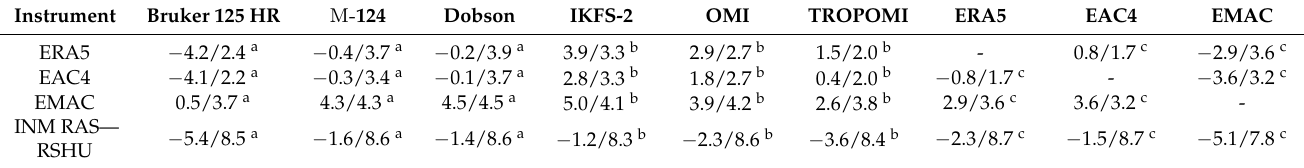
Table 6. Statistical characteristics of differences between original observed and simulated TOC near St. Petersburg for several time spans in the 2004–2019 period. MD and SDD relatively to Dobson mean TOC are shown in %. Letters in cells depict different time spans in which the data are compared